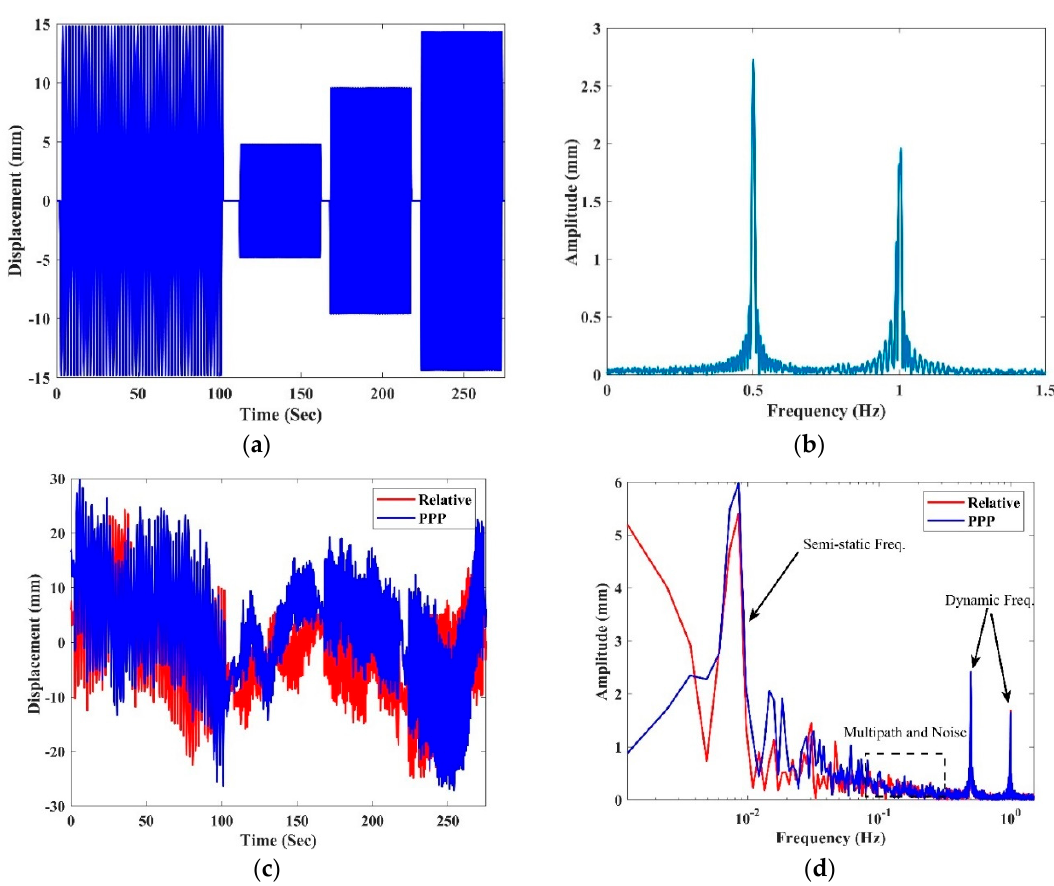
Figure 7. Four events amplitude ( a ) and frequency ( b ) for LVDT and amplitude ( c ) and frequency ( d ) for both GNSS solutions.